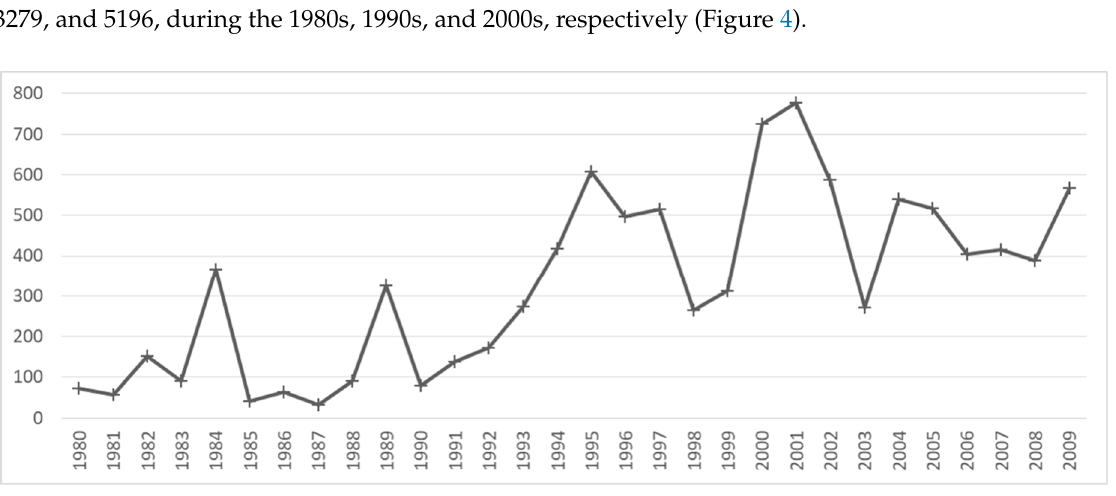
Figure 3. Number of annual forest fire occurrences from 1980 to 2009 based on the point location data. Data from the KFS.